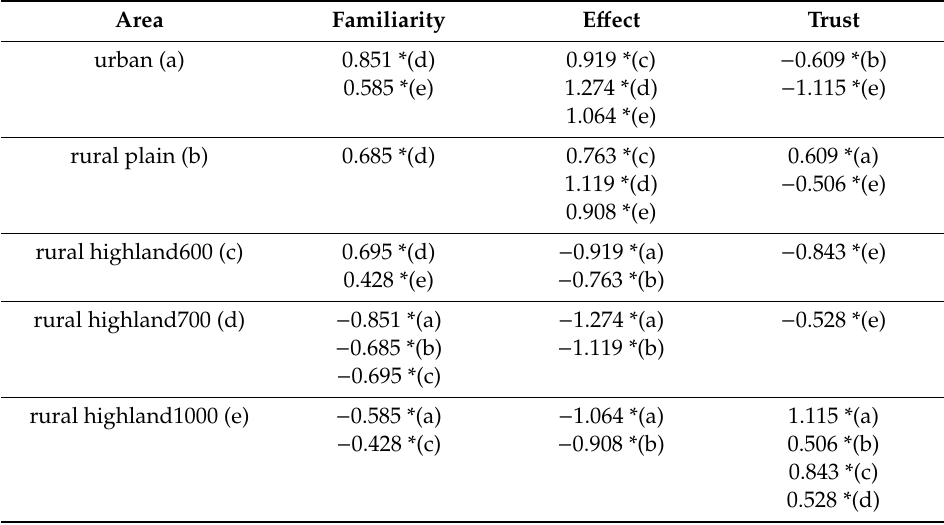
Table 3. Di ff erences of risk perception of air pollution via familiarity, e ff ect, and